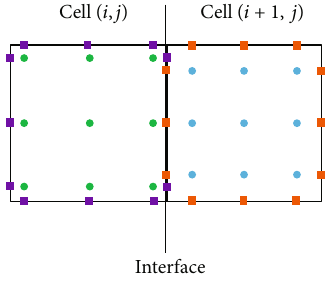
Figure 6: Distribution of di ff erent fl ux points on cell interfaces. Flux points of CPR are marked in purple square and those of WCNS in orange